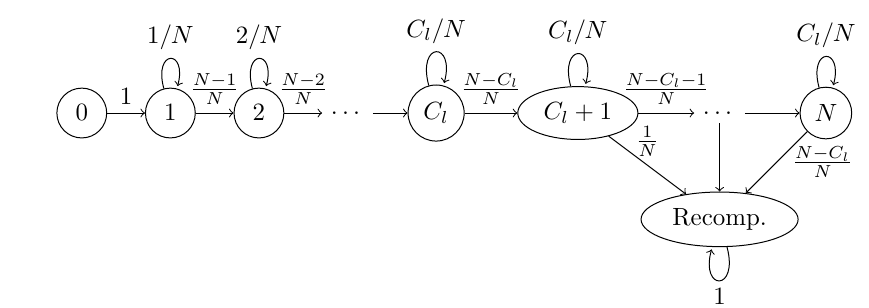
Figure 6: Markov chain representing the transitions from the cache being empty to any W-OTS + being recomputed. The states (others than “Recomp.”) count the number of cache misses without recomputation.